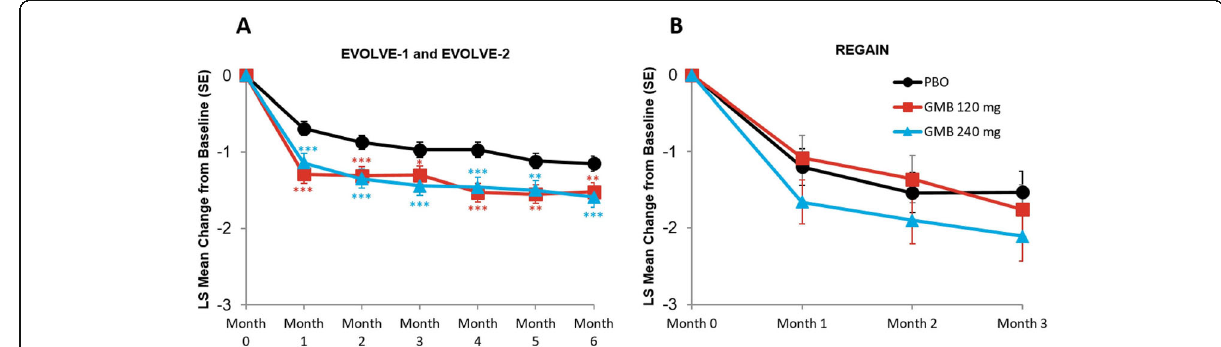
Fig. 4 Monthly mean change in monthly migraine headache days with aura. * p ≤ 0.05 vs PBO; ** p ≤ 0.01 vs PBO; *** p ≤ 0.001 vs PBO. GMB, galcanezumab; LS, least squares; PBO, placebo;SE, standard